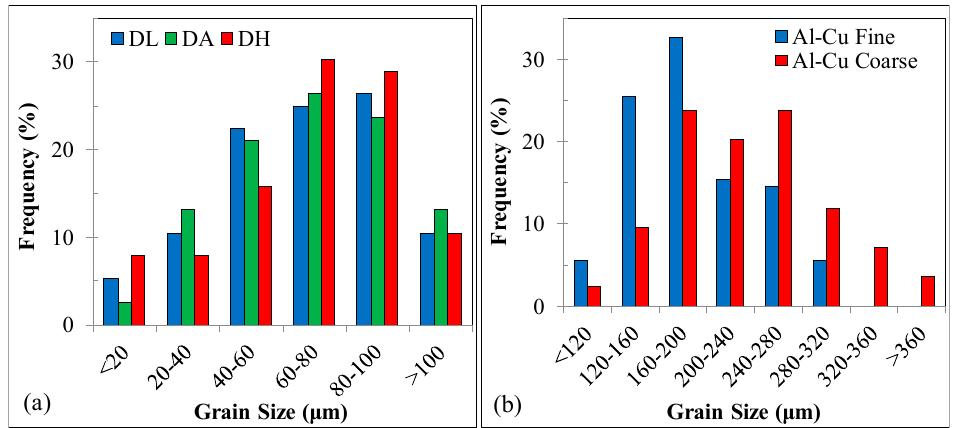
Figure 7. ( a ) Frequency distribution of grain size for A205 alloy through different size descriptors. ( b ) Frequency distribution of grain size measured by the linear intercept method for Al-Cu alloy with fine and coarse microstructures.